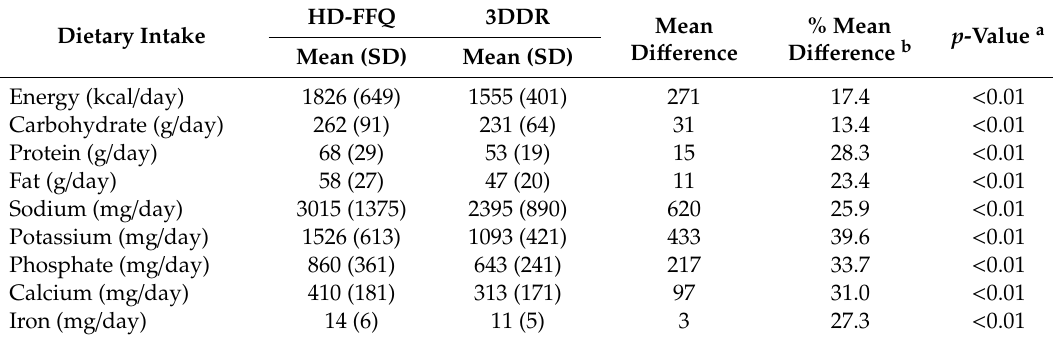
Table 5. Mean dietary nutrient intake and mean di ff erences between HD-FFQ and